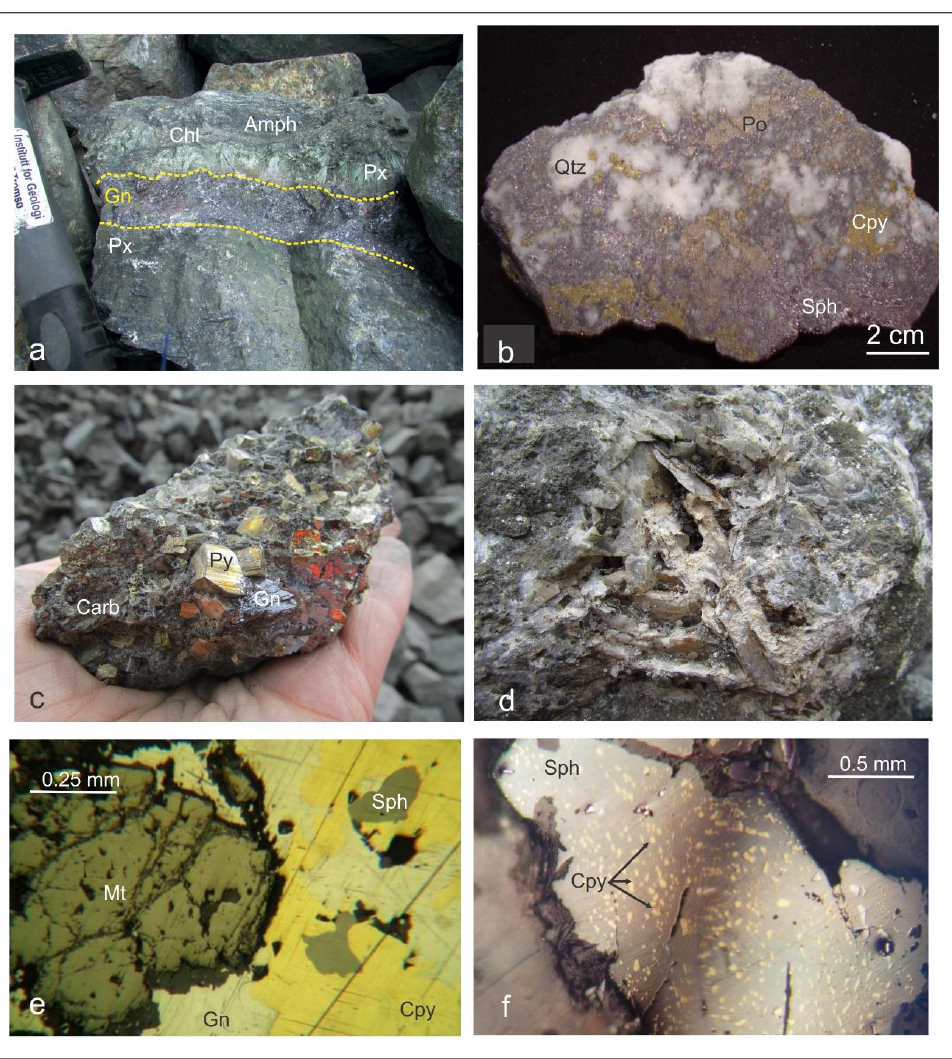
Figure 6. ( a ) The rhythmic banding of the prograde mineralization with the retrograde and hydrothermal mineral parageneses suggests that replacement processes were important mechanisms for the development of retrograde alterations, as well as for deposition of the hydrothermal mineralization; ( b ) Hand-specimen showing a typical hydrothermal paragenesis composed of pyrrhotite, chalcopyrite, sphalerite and quartz; ( c ) Hand-specimen consisting of pyrite, galena and carbonates reflects the open-space deposition of the hydrothermal mineralization; ( d ) Post-ore bladed calcite; ( e ) Reflected light photomicrograph of hydrothermal mineral paragenesis consisting of magnetite, chalcopyrite, galena and sphalerite; ( f ) Reflected light photomicrograph showing chalcopyrite disease in Fe-rich sphalerite. This texture is often interpreted as a diffusion-controlled replacement of the Fe-rich sphalerite mostly along crystal planes or controlled by